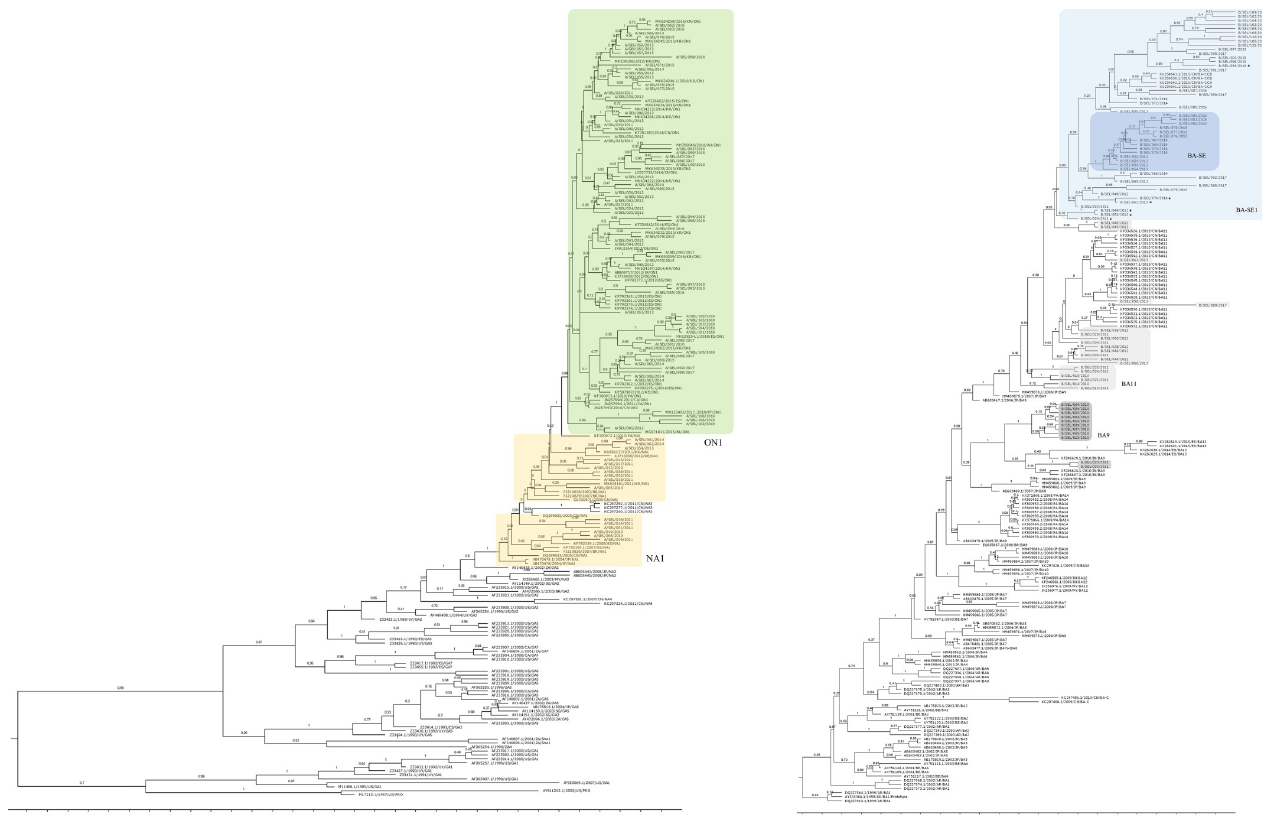
Fig 4. Maximum clade credibility (MCC) phylogenetic tree from Bayesian analysis of Seoul RSV-A and RSV-B strains. Time-scaled MCC trees based on the analysis of partial G gene sequence of RSV-positive samples from 2010–2019 in Seoul, (A) RSV-A and (B) RSV-B BA. (A) The RSV-A ON1 and NA1 genotypes were shaded in green and yellow boxes, respectively. The clusters of BA genotypes were shaded in mid-grey, light-grey, light-blue, and deep-blue boxes in BA9, BA11, BA-SE1, and BA-SE, respectively. The sequences showing discrepancies (BA-DIS) compared with the NJ and ML trees were marked with black asterisks in